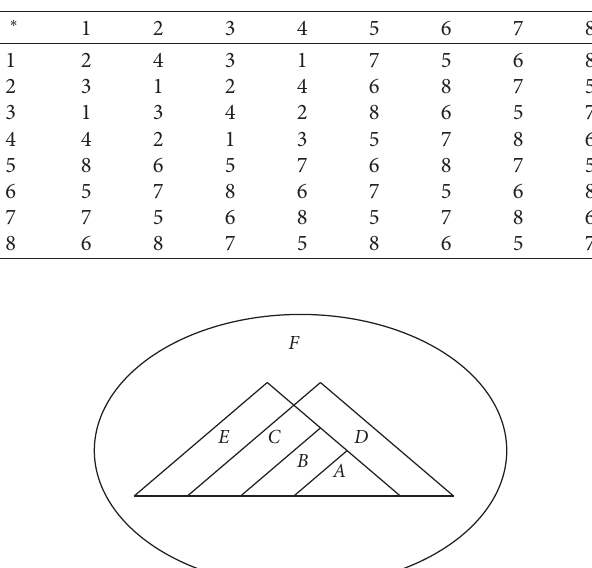
Table 8: Table of Example 8.